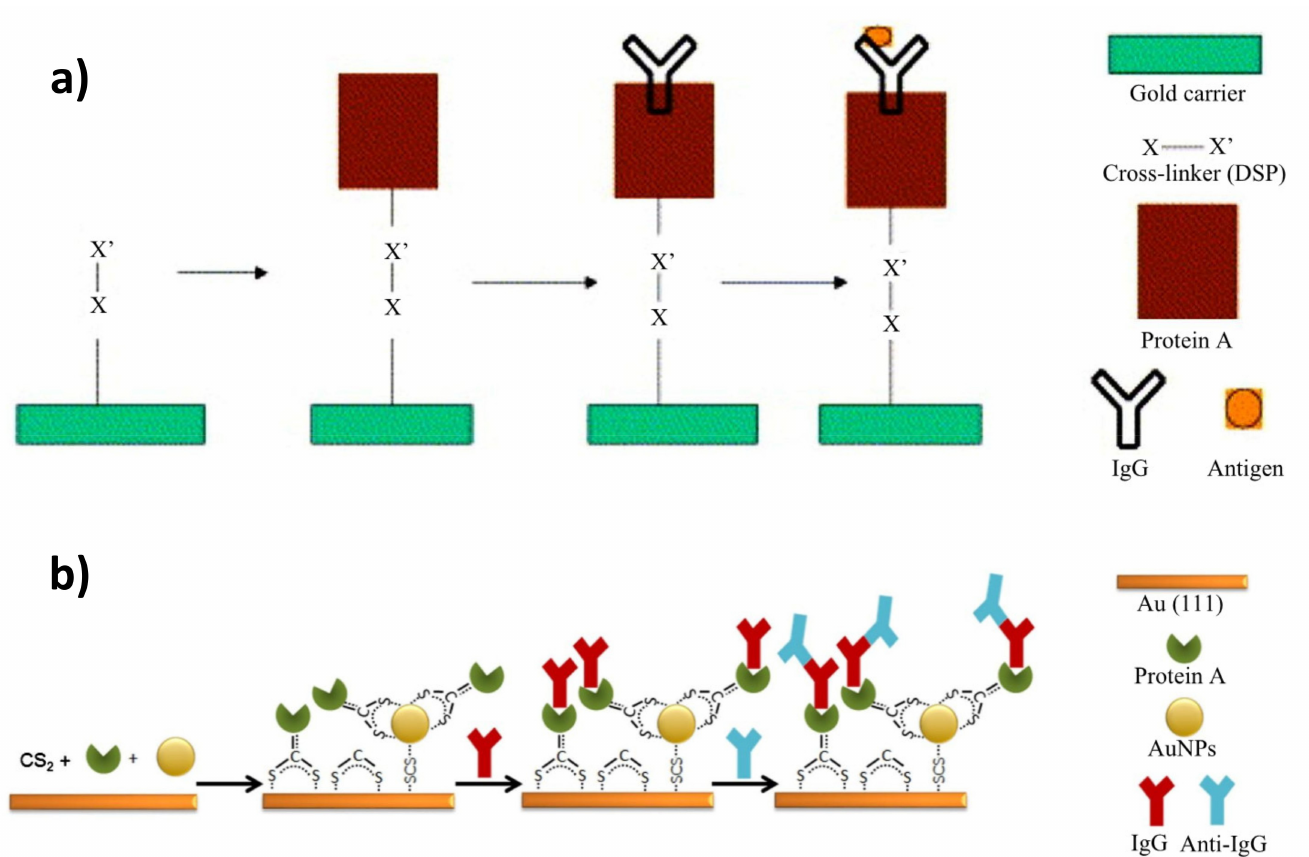
Figure 6. ( a ) Scheme of an SPR immunosensor construction based on the attachment of protein A to a gold surface through bifunctional DSP as a cross-linker, ( b ) functionalization of the terminal amino groups of protein A with carbon disulfide and direct immobilization of the carrier on gold by means of a dithiocarbamate assembly. Adapted with permission from Schmid et al. [120] (Copyright © (2006) Elsevier) and Paiva et al. [123] (Copyright © (2017)